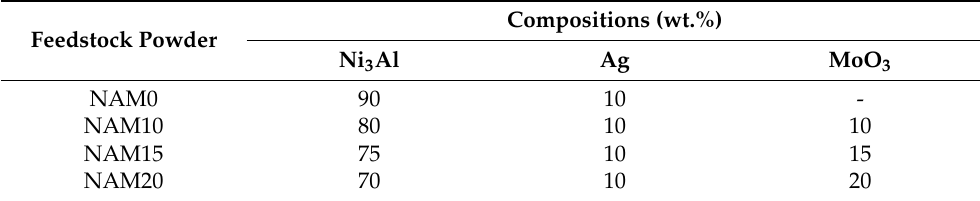
Table 1. Compositions of the NAM feedstock powder. Feedstock Powder